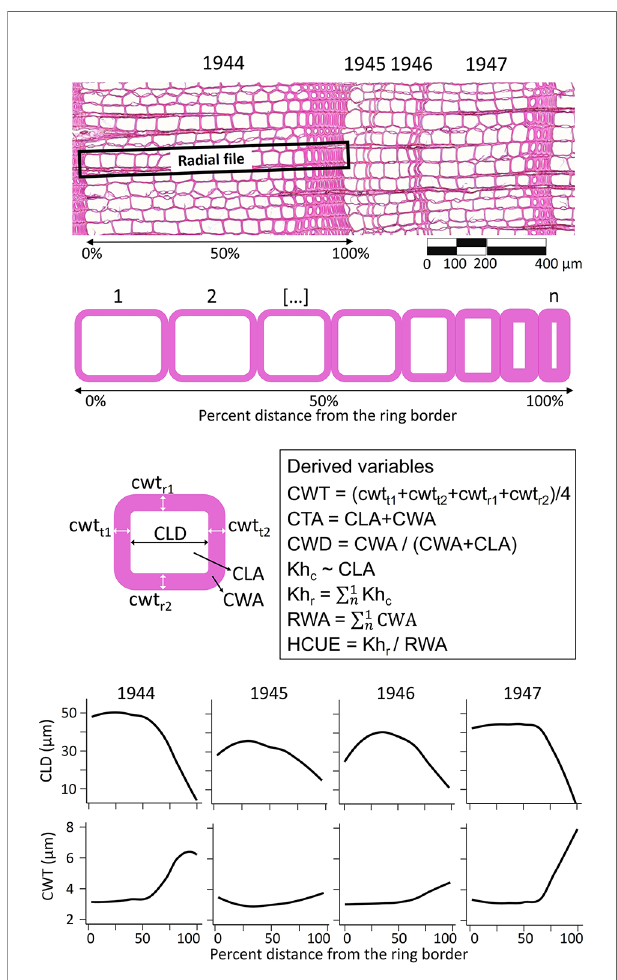
FIGURE 1 | Illustration of anatomical data extraction and computation. Within each ring and along each radial fi le, for every tracheid (from 1 to n, where n is the cell number, CN) we measured the cell lumen radial diameter (CLD), mean cell-wall thickness (CWT), cell lumen area (CLA), cell-wall area (CWA), cell total area (CTA), relative anatomical cell wood density (CWD), and theoretical cell hydraulic conductivity (Kh c ). From this information, we derived intra-ring pro fi les ( i.e. loess fi t of the anatomical parameter for each cell and its relative position in the ring, lower panels) and ring-based traits as theoretical tree-ring hydraulic conductivity (Kh r ), ring wall area (RWA), and hydraulic carbon use ef fi ciency (HCUE). Anatomical data used in this fi gure come from rings of a larch tree at S19, before (1944) and during the high-severity outbreak starting in